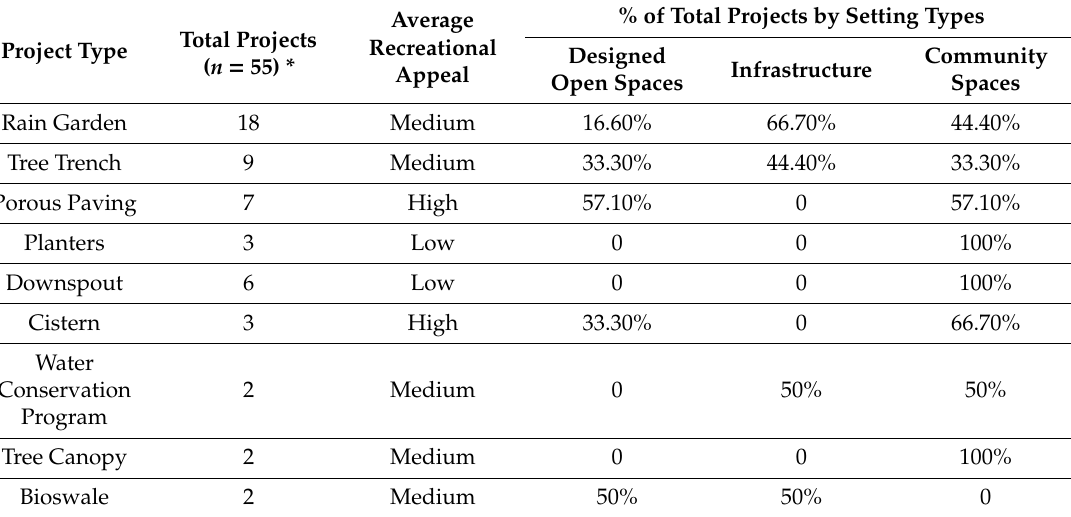
Table 3. Camden GSI Recreational Appeal and Project